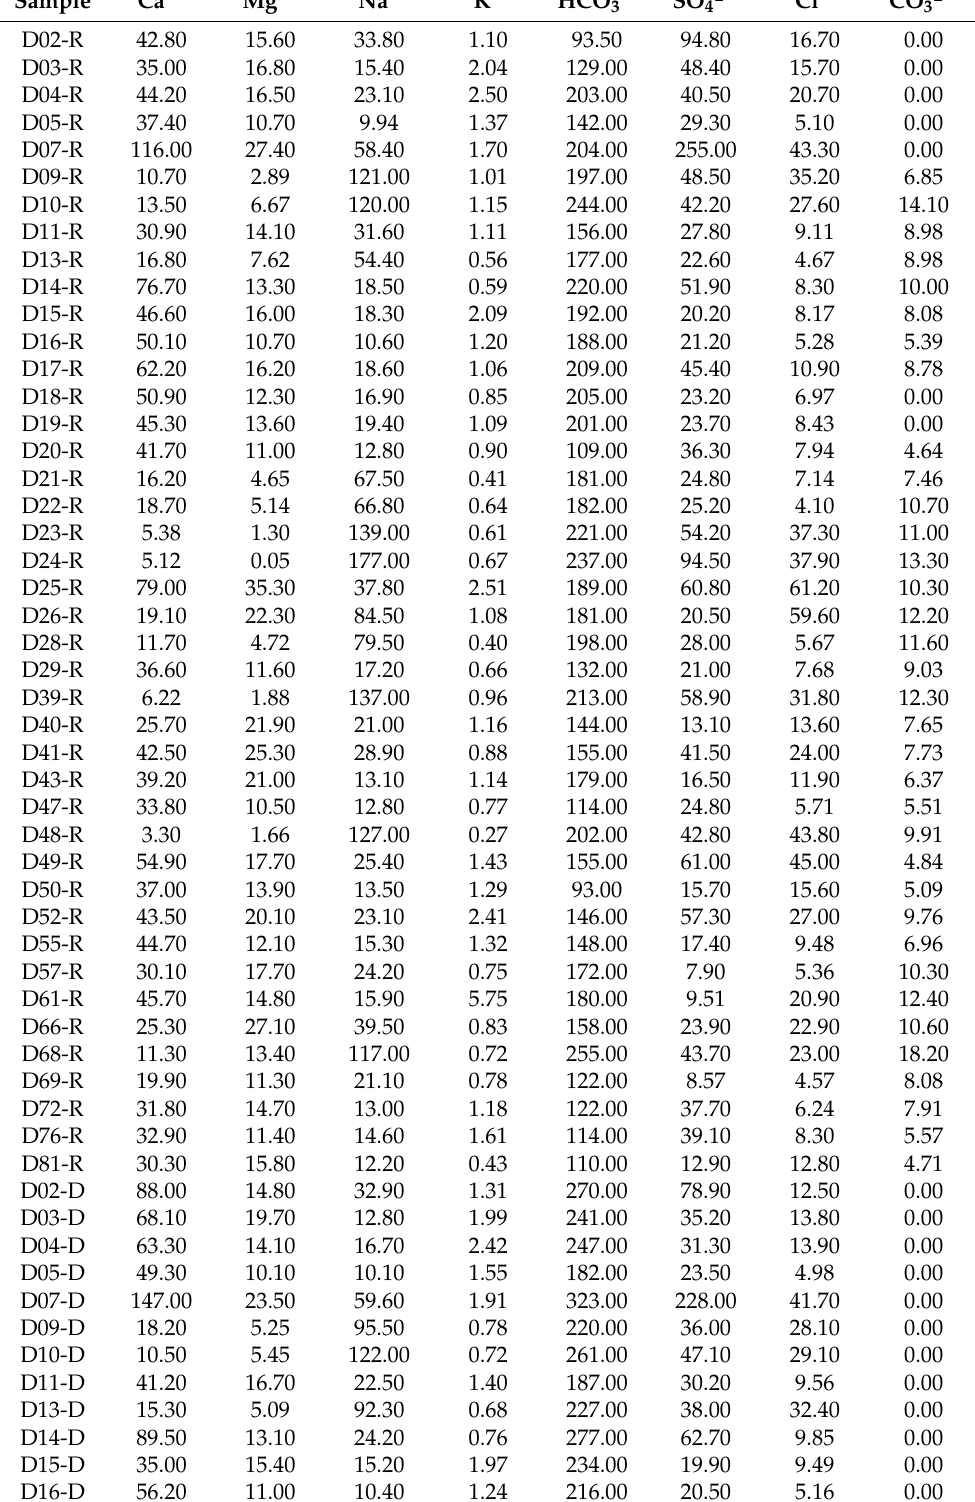
Table A1. Statistical summary for the hydrochemical parameters of groundwater samples (sample locations shown in Figure 1; D02-R represents the sample that was taken during the rainy season; and D02-D represents the sample that was taken during the dry season; unit: